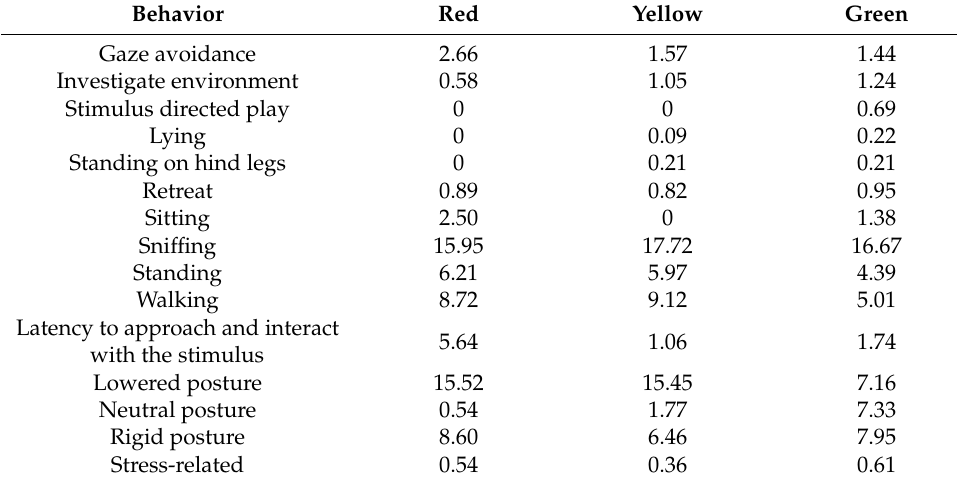
Table 5. Cross tabulation analysis for red, yellow, and green categories (based on [10]) for significant behaviors. Values in the table represent the average duration in seconds spent in the listed behavior when subjects were exposed to the dog statue